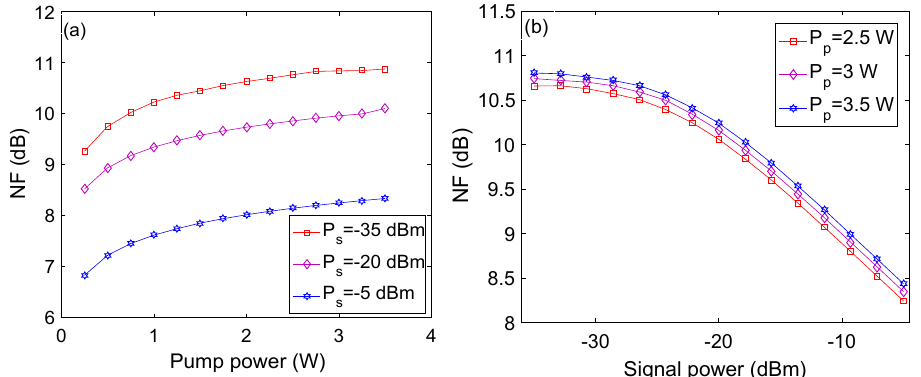
Figure 7. NF versus ( a ) pump power plots at different input signal powers ( b ) signal power plots at different pump